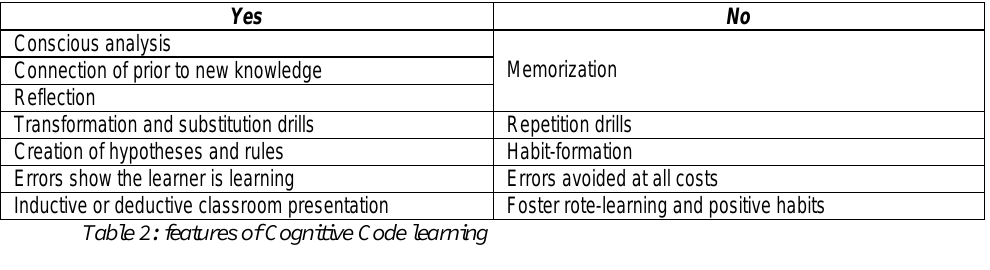
Table 2: features of Cognitive Code